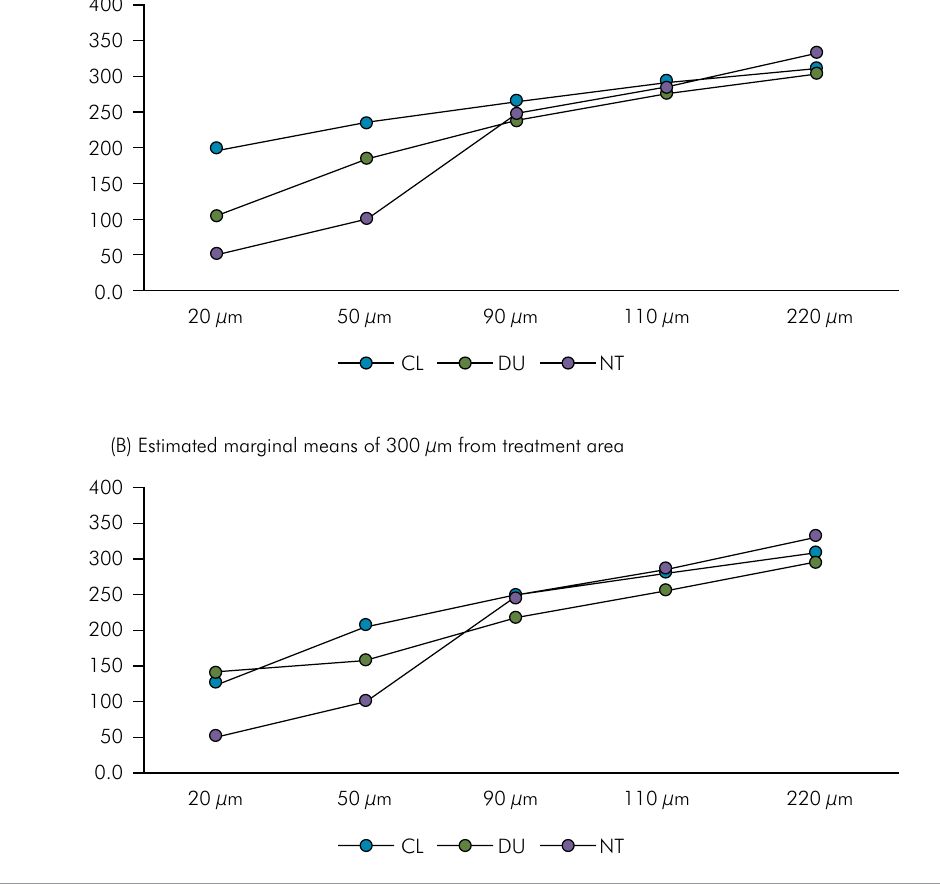
Figure 4. Mean values of enamel Knoop hardness (Kg/mm) and distance (µm) at (A) 150 μ m, (B) 300 μ m, and (C) 450 μ m from the surface in the treatment